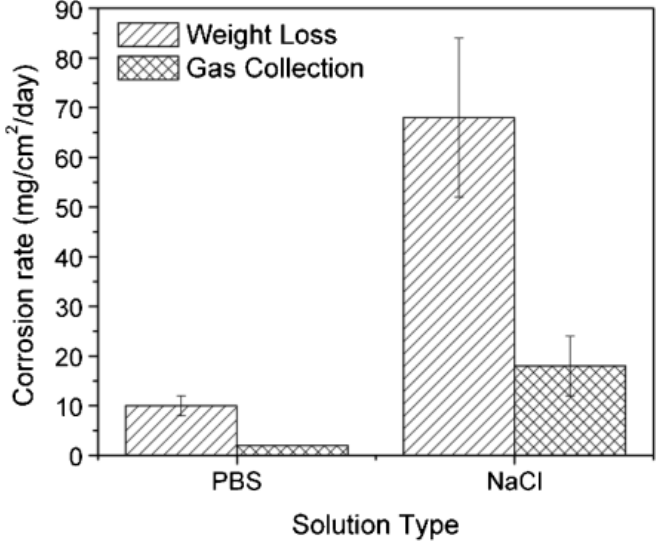
Figure 9. Corrosion rates from gas volume collection and weight loss measurements during the Mg alloy corrosion in 3.5% NaCl and pH 7.4 phosphate-buffered saline. Reproduced with permission alloy corrosion in 3.5% NaCl and pH 7.4 phosphate-bu ff ered saline. Reproduced with permission from ref. [113]. Copyright 2013 Wiley.